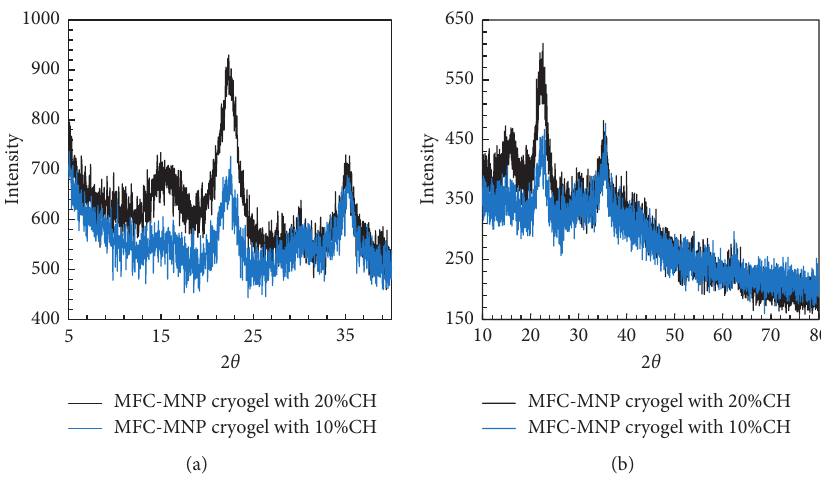
Figure 5: XRD patterns of MMFC cryogels at small (a) and wide (b) angles.